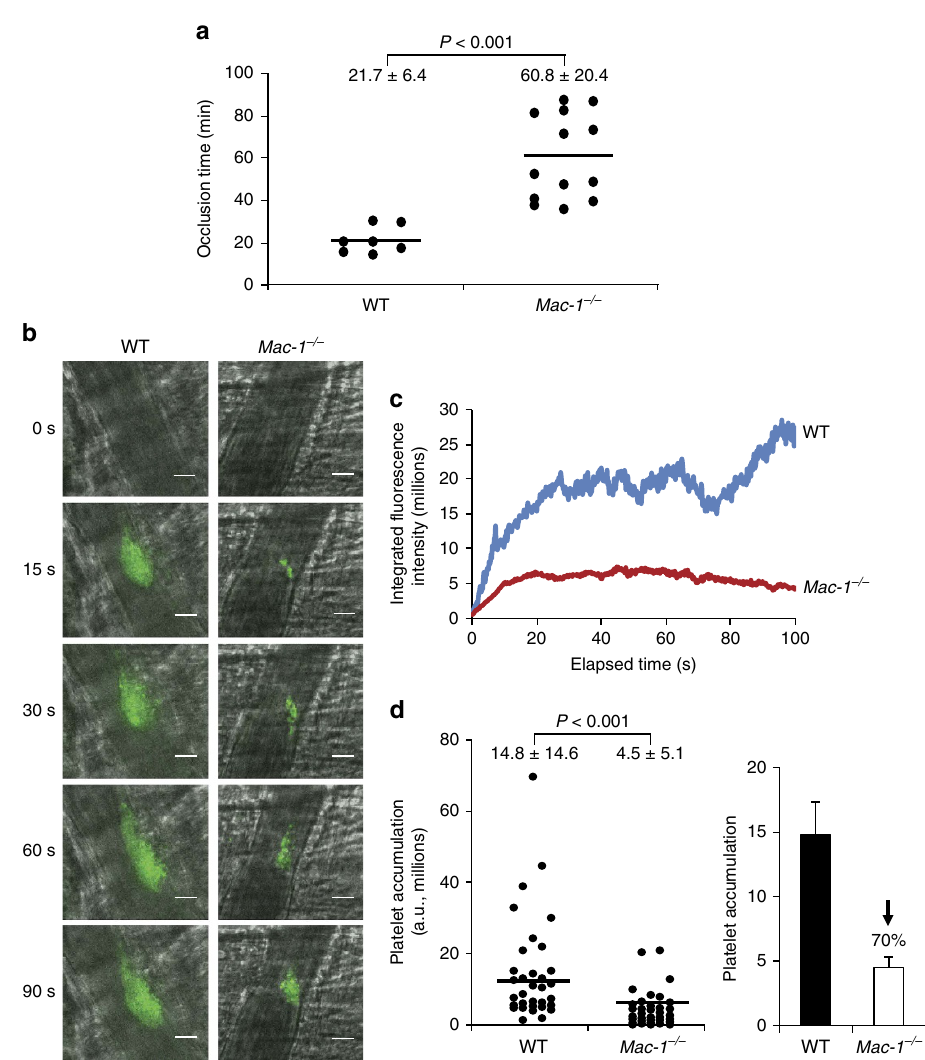
Figure 1 | Deficiency of Mac-1 prolongs thrombotic occlusion time. ( a ) Occlusion time (min) following photochemical injury of the carotid artery in 7- to 8-week-old male WT ( n ¼ 7) and Mac-1 (cid:2) / (cid:2) ( n ¼ 13) mice (mean ± s.d.). Thrombus formation after laser-induced injury to the arteriolar wall of the cremaster microvasculature of Mac-1 (cid:2) / (cid:2) mice was compared with that of WTmice using intravital microscopy ( b – d ). Platelets were labelled in vivo using a fluorescein isothiocyanate-conjugated rat anti-mouse CD41 antibody. ( b ) Representative intravital images at indicated times following laser pulse ( n ¼ 33–35 per group). Scale bar, 20 m m. ( c ) Continuous, real-time thrombosis profiles of one representative experiment ( n ¼ 33–35 arterioles per group). ( d ) Mean fluorescence intensity of platelets in individual arterioles over time. Each data point is from a single arteriole. Data (mean ± s.d.) taken from four WT and four Mac-1 (cid:2) / (cid:2) 11- to 12-week-old male mice. P values are obtained by two-tailed unpaired t- staining) is similar in Mac-1 (cid:2) / (cid:2) platelets compared to not reduced in Mac-1 (cid:2) / (cid:2) plasma (WT: 21,055 ± 407 versus Mac-1 (cid:2) / (cid:2) : 22,398 ± 830 a.u., n ¼ 4 per group; Fig. 2c). Taken WT platelets in response to the treatment of thrombin (Supplementary Fig. 1a,b), collagen (Supplementary Fig. 1c,d) together, these data indicate that neither platelet count nor or arachidonic acid (Supplementary Fig. 1e,f). In addition, coagulation parameters likely account for delayed thrombosis in Mac-1 (cid:2) / (cid:2) mice. adhesion (Supplementary Fig. 1g) and spreading on collagen (Supplementary Fig. 1h) between WT and Mac-1 (cid:2) / (cid:2) mice. Unimpaired platelet activation and signalling in Mac-1 (cid:2) / (cid:2) platelets . Although leukocyte-restricted expression of Mac-1 Transfer of WT leukocytes restores thrombosis defect in makes it unlikely that defective thrombus formation in Mac-1 (cid:2) / (cid:2) mice . Although we have provided evidence that Mac-1 (cid:2) / (cid:2) mice is due to an intrinsic platelet activation defect, we nonetheless assessed platelet activation in platelets isolated deficiency of Mac-1 is associated with prolonged time to carotid from WT and Mac-1 (cid:2) / (cid:2) mice by monitoring the expression of artery occlusion after photochemical injury, we have utilized mice P-selectin and activated a IIb b 3 (GPIIb/IIIa) in response to agonist with global rather than tissue- or cell-specific deficiency of Mac-1, stimulation. Washed platelets from WT and Mac-1 (cid:2) / (cid:2) mice thereby limiting our ability to conclude definitively that leukocyte were stimulated with collagen, thrombin or arachidonic acid. Mac-1 is critical for thrombus formation. To address this Platelet activation as measured by both P-selectin expression issue, we performed adoptive transfer experiments of WT and (Wug.E9-positive staining) and activated a IIb b 3 (JON/A-positive Mac-1 (cid:2) / (cid:2) donor peripheral blood mononuclear cells (PBMCs)